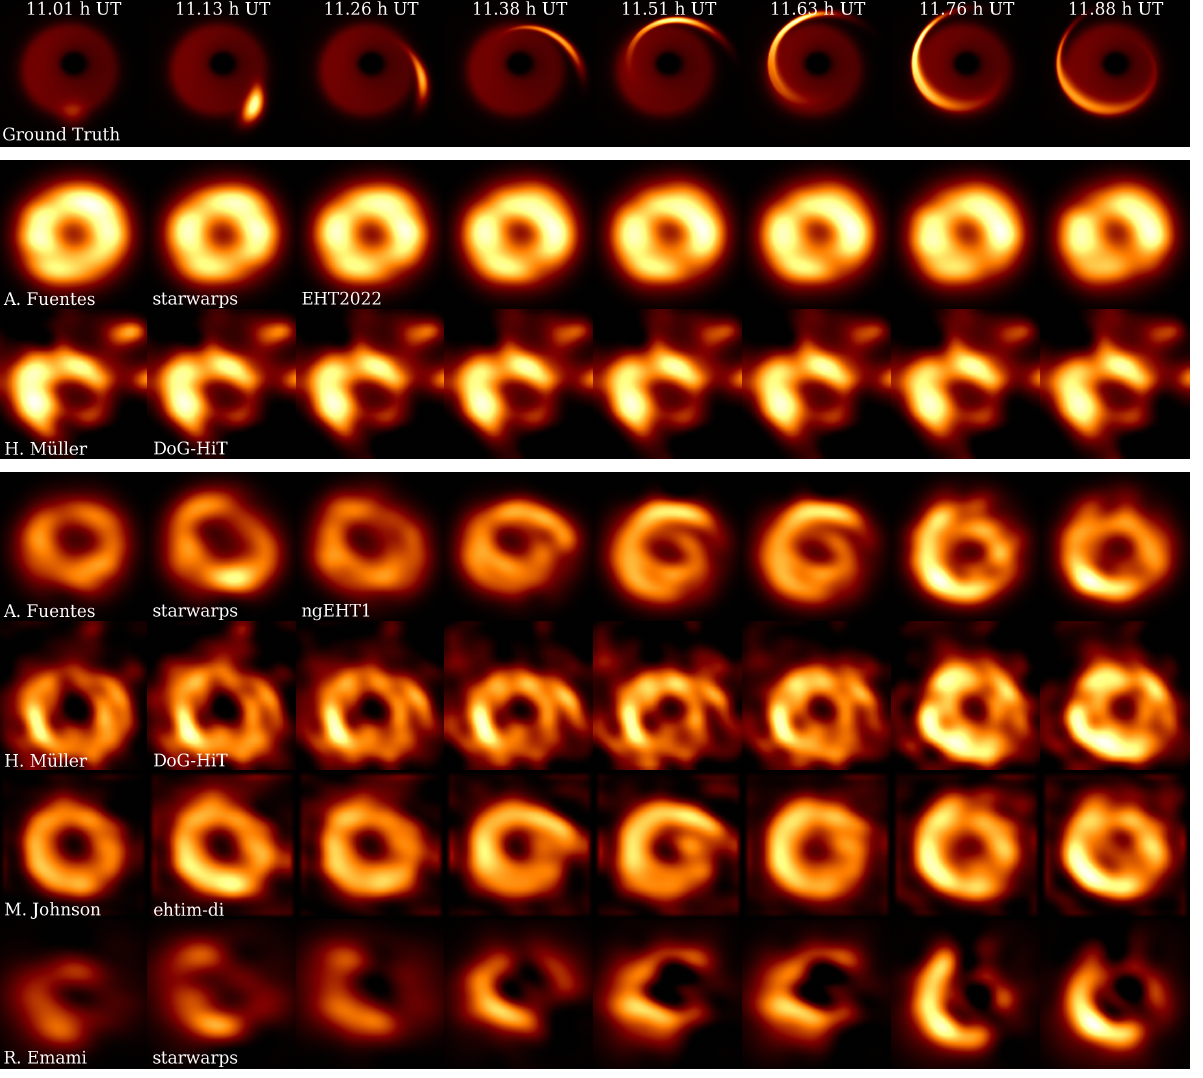
Figure 12. Challenge 2 Sgr A* RIAF+hotspot 230 GHz submissions. Images are shown on a linear scale, which is normalized to the brightest pixel value across each submitted set of movie frames on a field of view of 126 µ